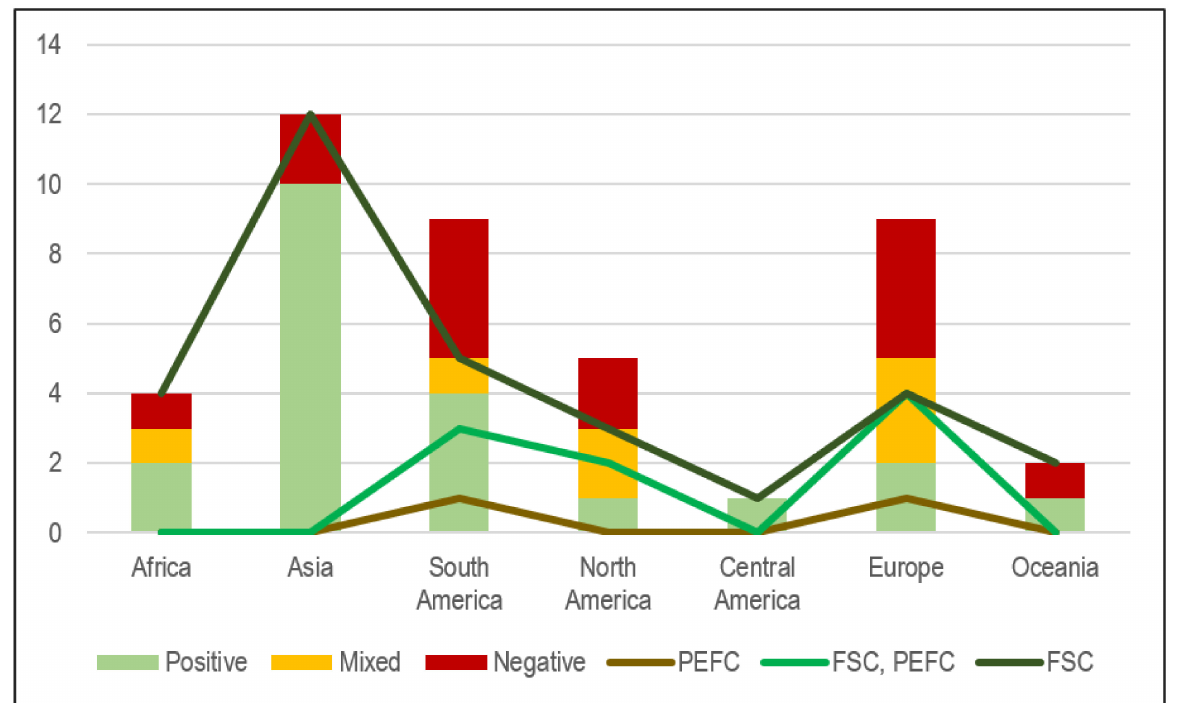
Figure A4. Distribution of empirical studies on economic viability, illustrated by impact and certifica- tion